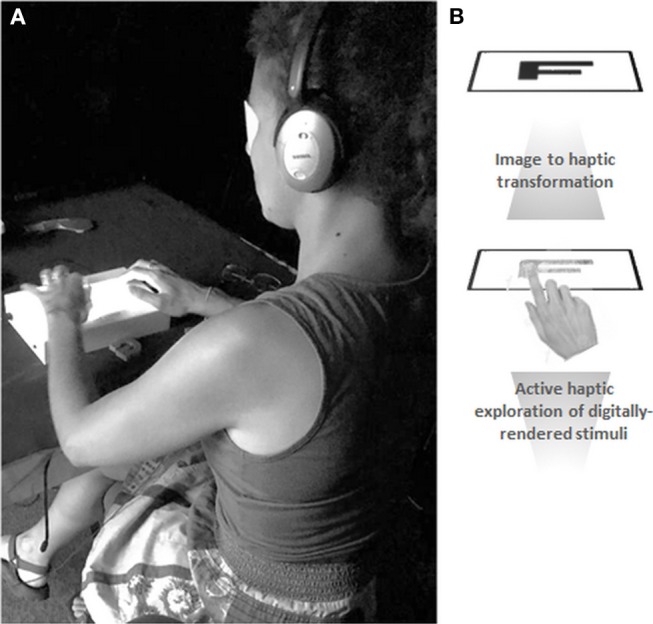
Experimental setup and digital haptic transformation. (A) Each subject wore a blindfold and noise-canceling earphones throughout the experiment. This was done to prevent any residual or inadvertent visual input and to mask any audible noise from the tablet. During each trial, the subject could explore the letter stimulus for 30 s with one finger of their dominant hand. They then used their non-dominant hand to respond via a computer mouse whether the letter was upright or mirror-reversed. (B) The tablet's pre-installed software development kit translated the image files into haptic renderings. The transformation involves delineating the image in a series of 8 × 8 pixel cells and coding each of the cells into textures, using a haptic library where different textures are defined. Written informed consent was obtained from the individual for the publication of this image.